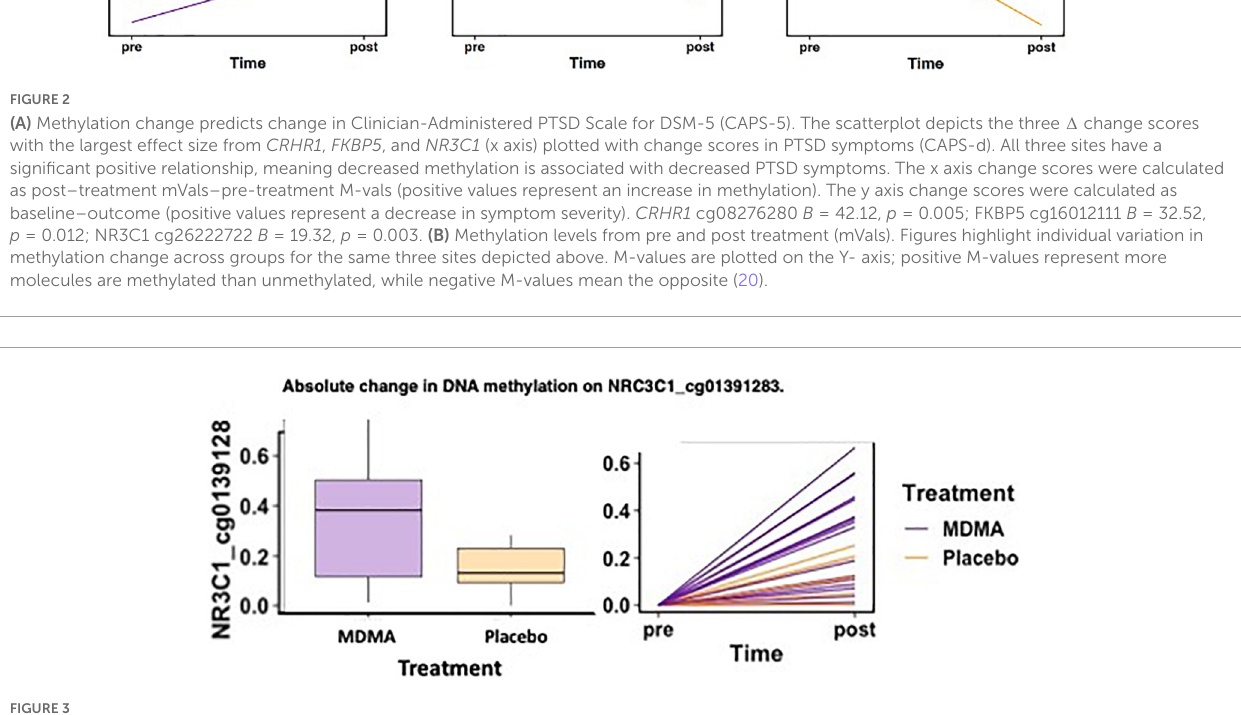
FIGURE3 MDMA-assisted therapy group had more absolute change in methylation on NRC3C1_cg01391283 compared to the placebo group. Change in DNA methylation (abs (cid:49) ) at NRC3C1_cg01391283 from pre-treatment to post-treatment [ F (1, 18) = 4.78, p =